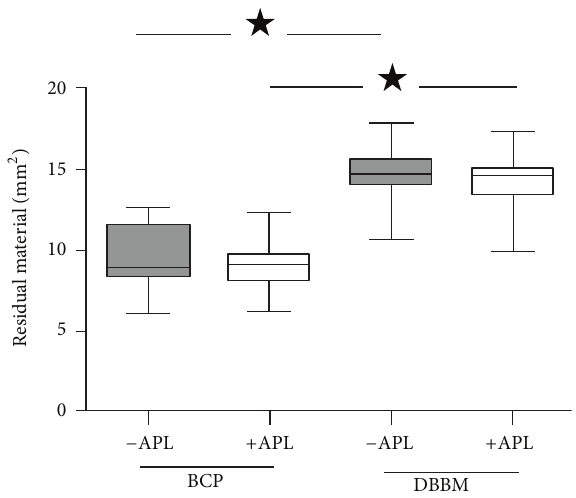
Figure 6: Box plot showing residual material area in the defect at 6 weeks after implantation. In the defects filled with DBBM, the amount of residual material was significantly ( ∗ P < 0.0001) higher than that observed in the defects filled with BCP.